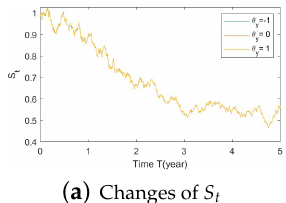
Figure A4. Illustrate the impact on ( a ) stock prices, ( b ) driver of volatility, ( c ) driver of elasticity, ( d ) elasticity of volatility, and ( e ) optimal stock allocations when varying the speed of reversion, κ y ( e . g ., κ y = 0.5,2,10 ) .